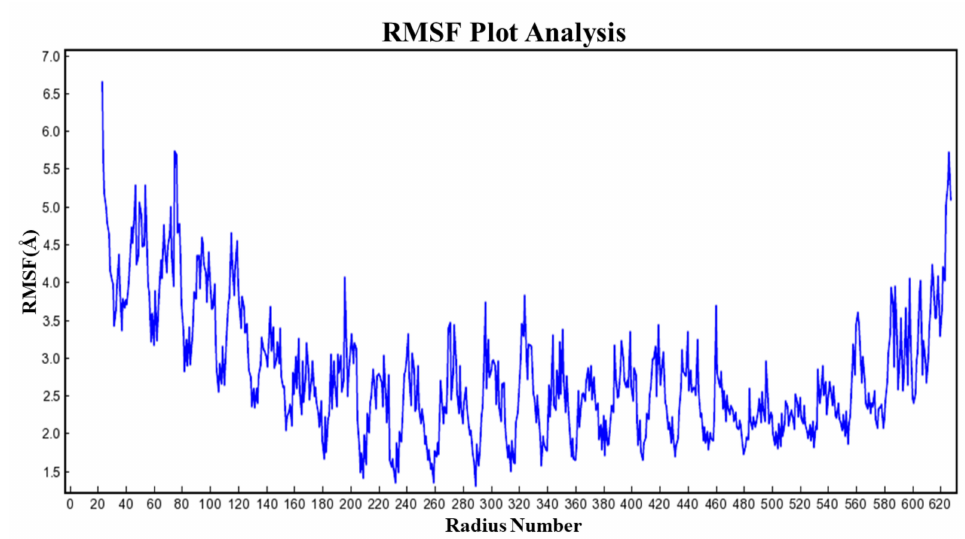
Figure 9. The MD simulation analysis using the root mean fluctuation (RMSF) plot. The molecular dynamic simulation revealed that the RMSF value of the TLR-4 and rutin complex was within the acceptable range and no significant deviation was noted.